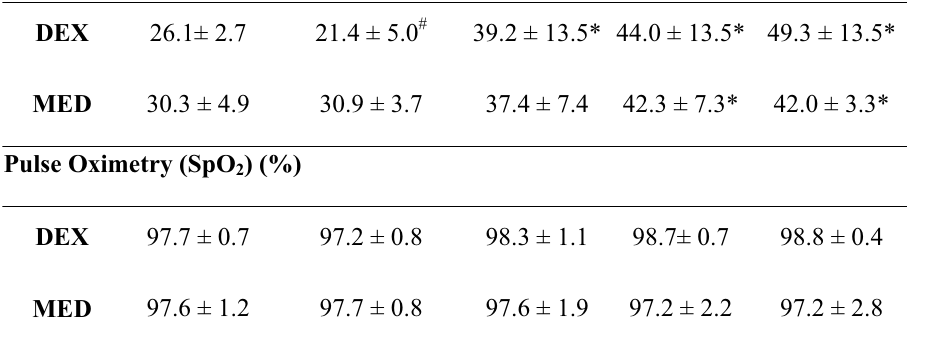
*P<0.05: versus control at the same group; values as mean ± standard